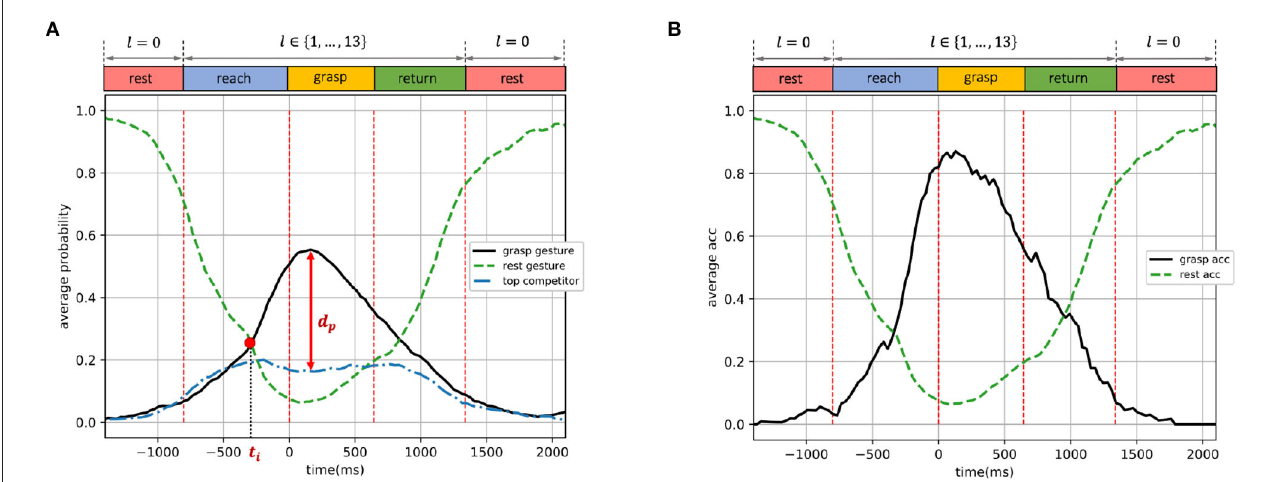
FIGURE 8 | Dynamic-EMG gesture classifier trained by the second strategy (grasping and resting phases): predicted probabilities and accuracy on validation set, presented as functions of time. (A) Average predicted probabilities. (B) Average